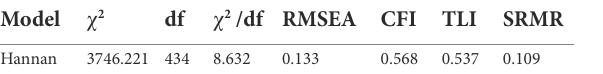
TABLE 5 Common method bias test (N = 431).